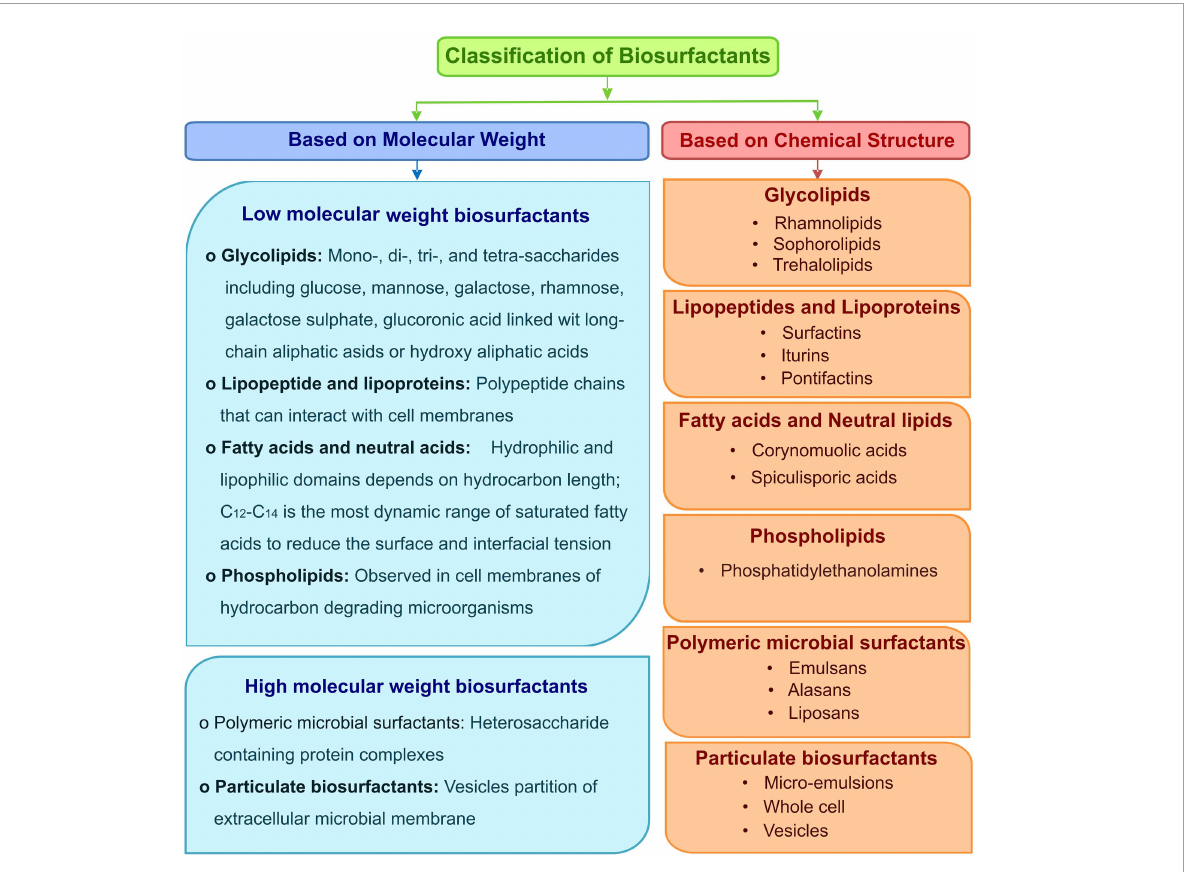
FIGURE1 Classification of biosurfactants based on the chemical